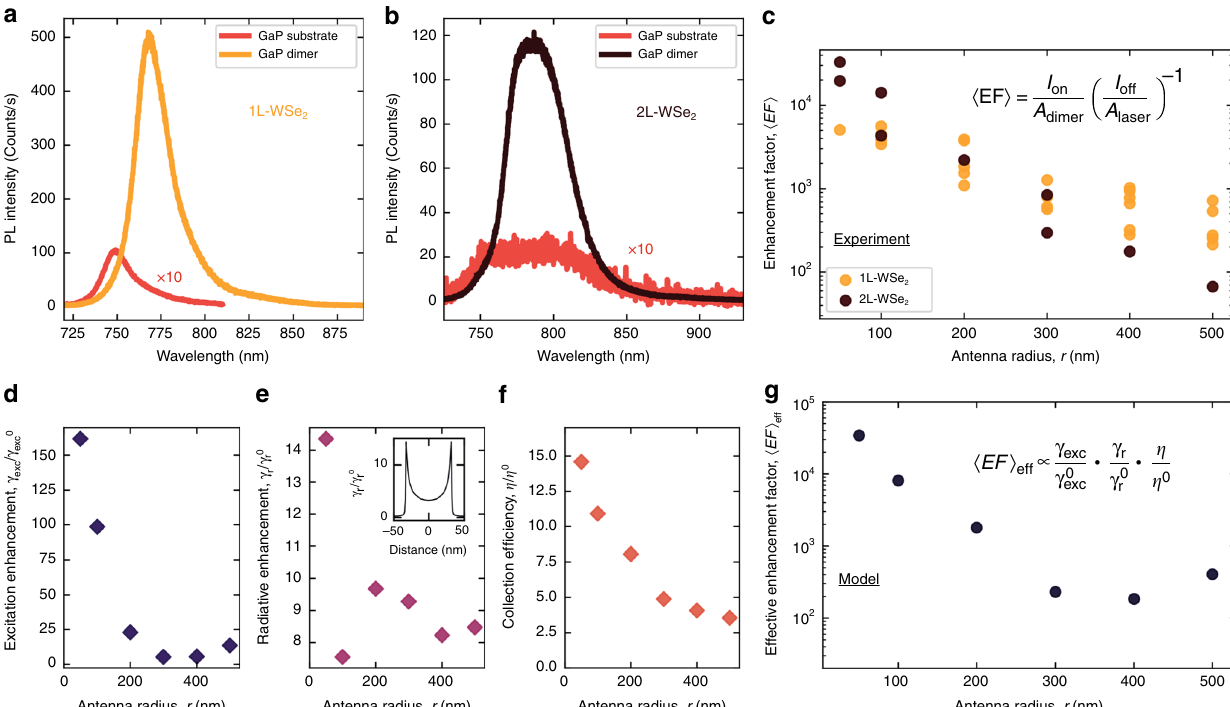
Fig. 2 Photoluminescence enhancement of monolayer and bilayer WSe 2 coupled to GaP nano-antennas. a , b PL spectra for 1L-WSe 2 (orange) and 2L-WSe 2 (black) placed on top of GaP nano-antennas with r = 300 and 100 nm, respectively. Spectra in red are measured on 1L- ( a ) and 2L-WSe 2 ( b ) placed on the planar GaP. Their intensity is multiplied by 10. c Experimental PL enhancement factor, h EF i , as a function of the antenna radius, for 1L- (orange) and 2L-WSe (black). d – g Results of simulations showing various parameters determining the observed PL enhancement in a dimer as 2 a function of the pillar radius (see main text and ‘ Methods ’ for further details). The values shown in the fi gures correspond to the behaviour of an oscillating electric dipole placed at the edge of the gap between the two pillars, 0.5 nm above the top of the pillar, and aligned along the line connecting the centres of the pillars [see inset in e ]. d Enhancement of the excitation, γ antenna surface and on the planar GaP substrate. e Enhancement of the radiative recombination rate, γ function of the dipole position above the dimer gap. The values plotted in d – g are calculated for the dipole placed at the position where γ reaches the maximum. f Enhancement of the light collection ef fi ciency, η = η 0 . g Dependence on r of the calculated effective enhancement factor, h EF i , de fi ned as the product of the parameters in d – f (see Eq. (2) and the formula on the eff